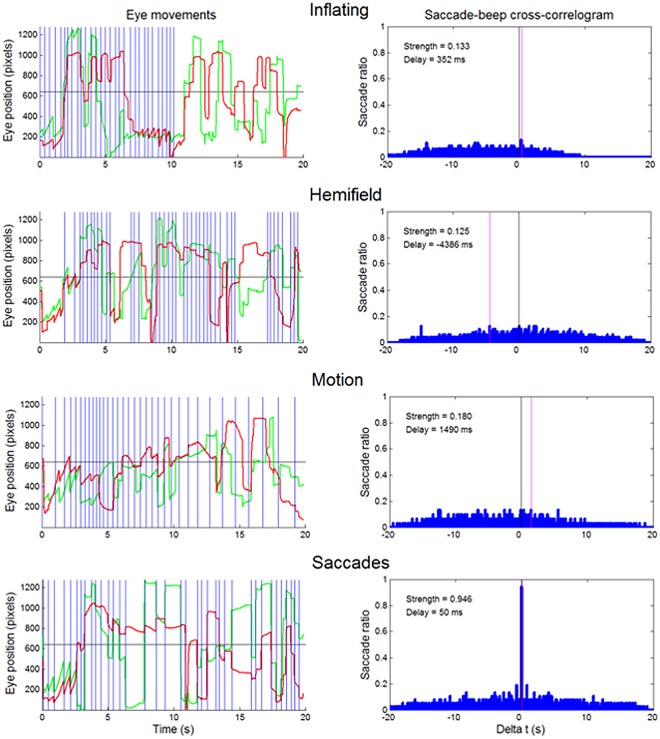
Examples of the temporal relation between saccades and beeps in single trials.Left panels, eye movement traces (green traces: horizontal component of eye position, red traces: vertical component) and beep occurrence (blue vertical lines). Right panels, saccade-beep cross-correlograms. The vertical black and magenta lines indicate zero-delay and the actual delay, respectively.